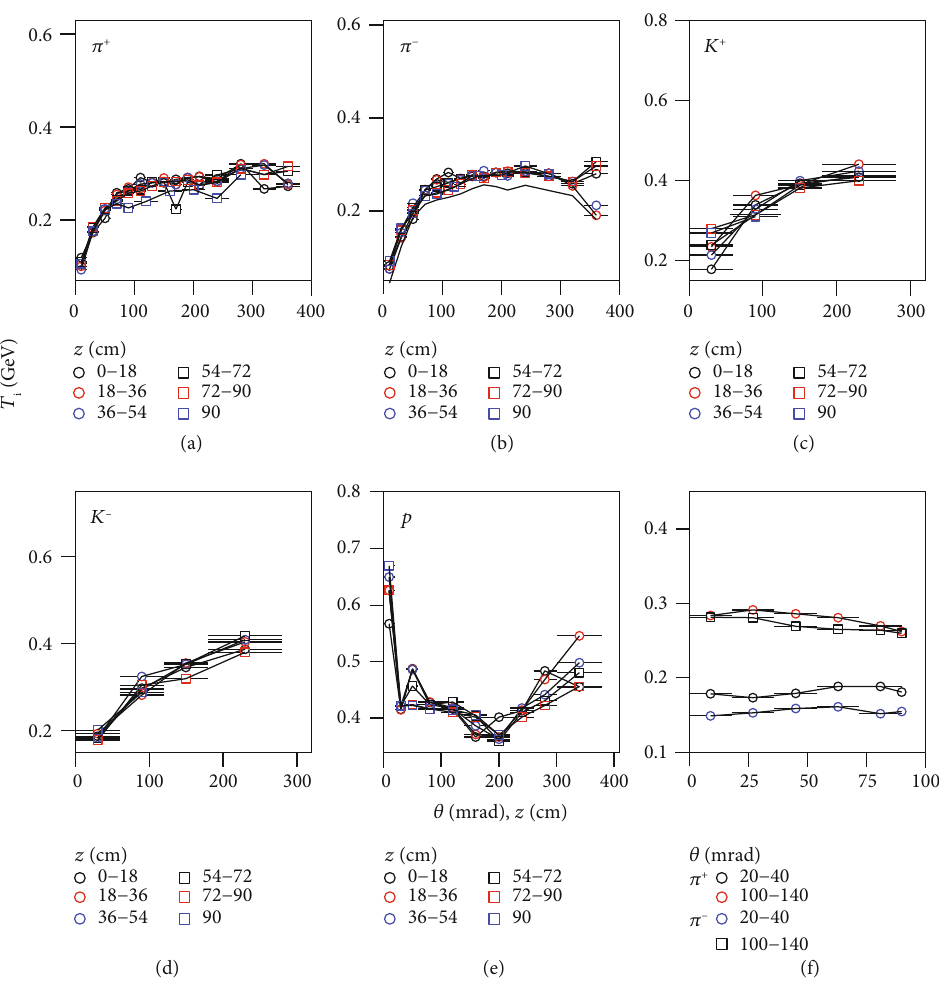
Figure 13: Same as Figure 12 but showing the dependence of T